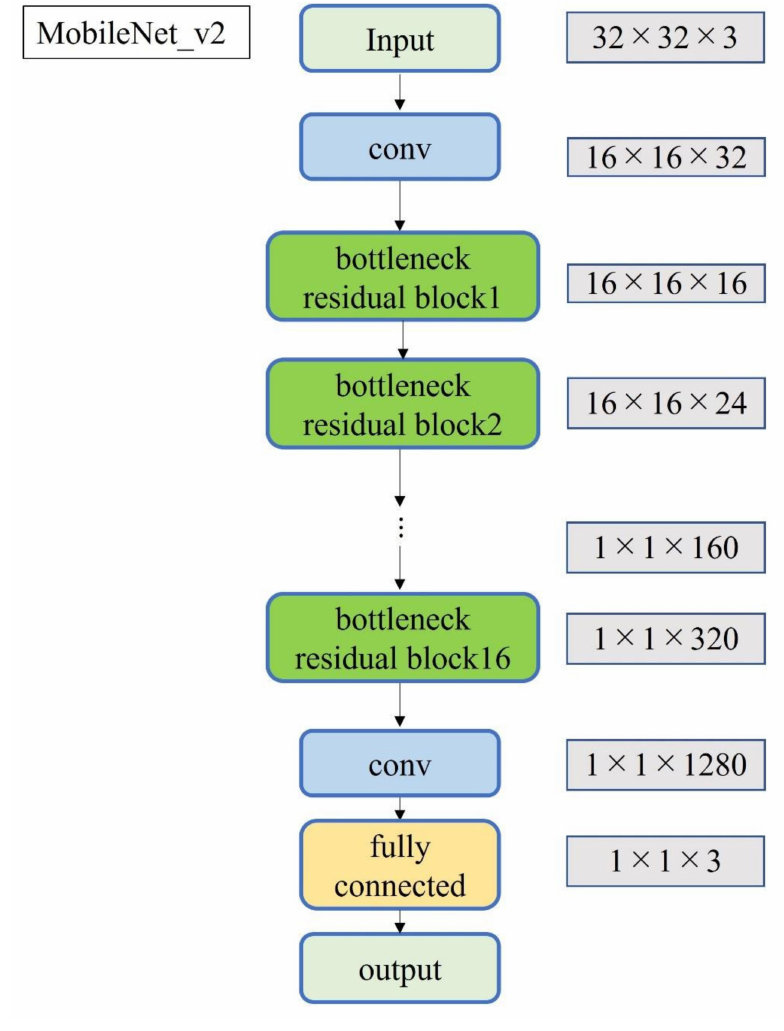
Figure 5. Block diagram of MobileNet_v2. Table 1. Best parameters of the training